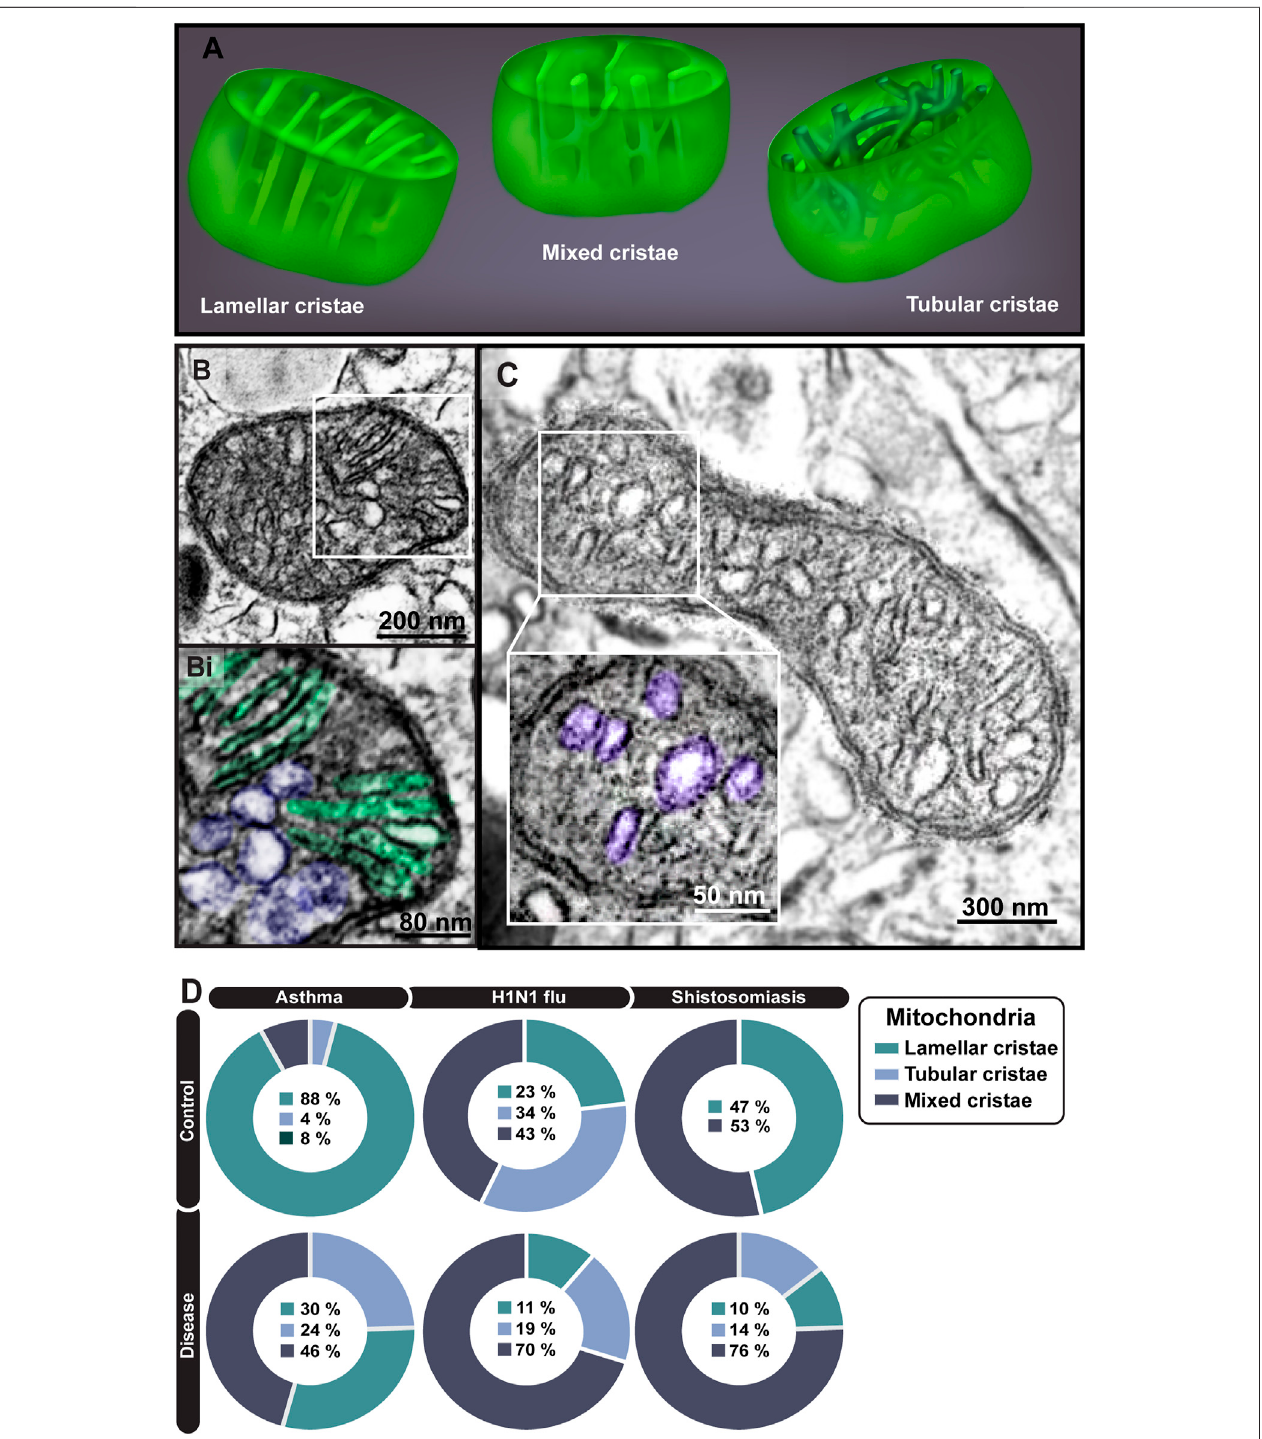
FIGURE 8 | Ultrastructural aspects of mitochondrial cristae within mouse eosinophils. (A) Illustration depicting the three types of cristae — lamellar, tubular, and mixed.In (B) ,arepresentativemitochondrionwithbothlamellar(highlightedingreeninBi)andtubular(highlightedinpurpleinBi)cristaewhile (C) showsamitochondrion with predominantly tubular cristae (colored in purple in Ci). (D) Cristae remodeling is observed in all diseases in in fl ammatory eosinophils compared to resident ones. A total of 795 mitochondria were evaluated at high resolution within 116 cells collected from at least fi ve independent experiments for each condition. Cells were prepared for